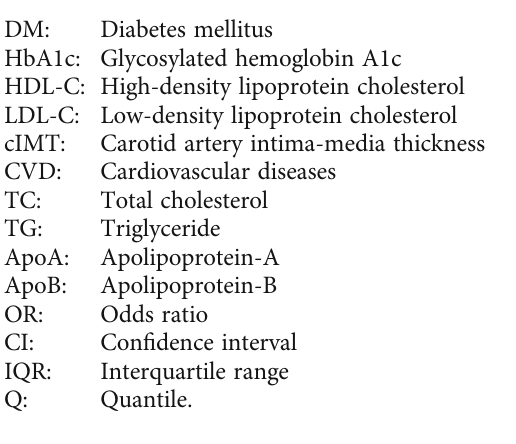
Supplemental Table 1: baseline information according to quartiles of the HbA1c/HDL-C ratio in patients with DM ( N = 450 ). Supplemental Table 2: baseline information according to quartiles of the HbA1c/HDL-C ratio in patients without DM ( N = 854 ). Supplemental Table 3: